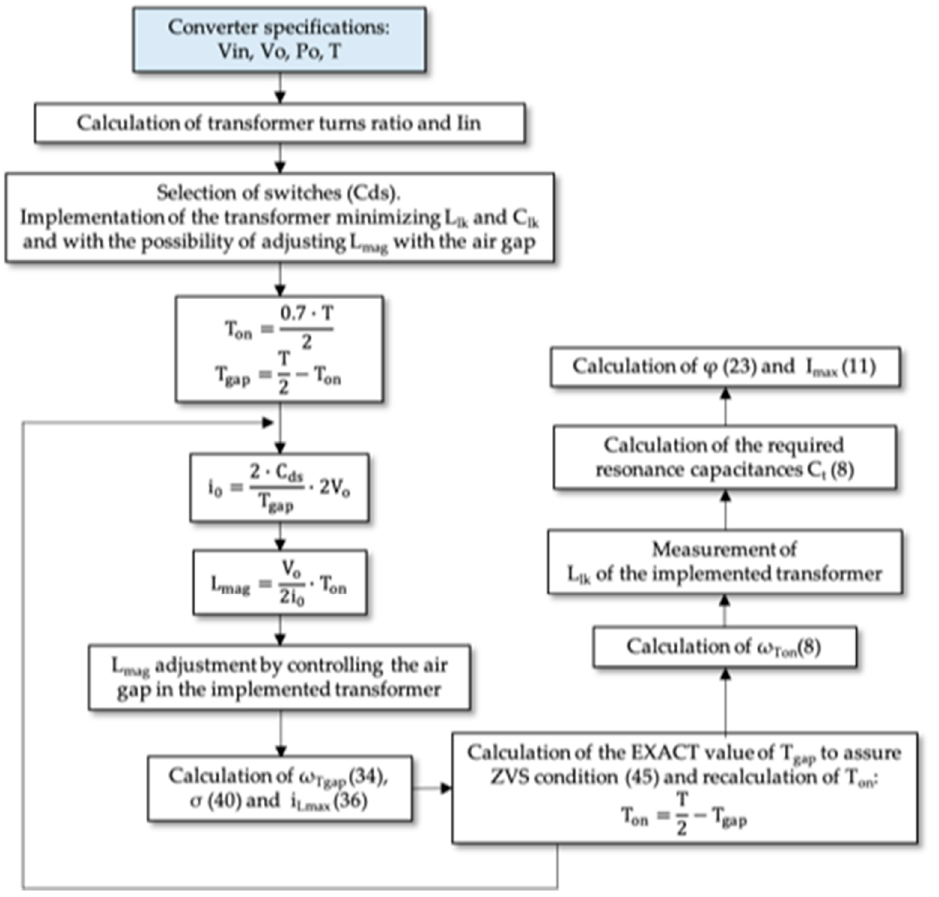
Figure 10. Design flowchart.